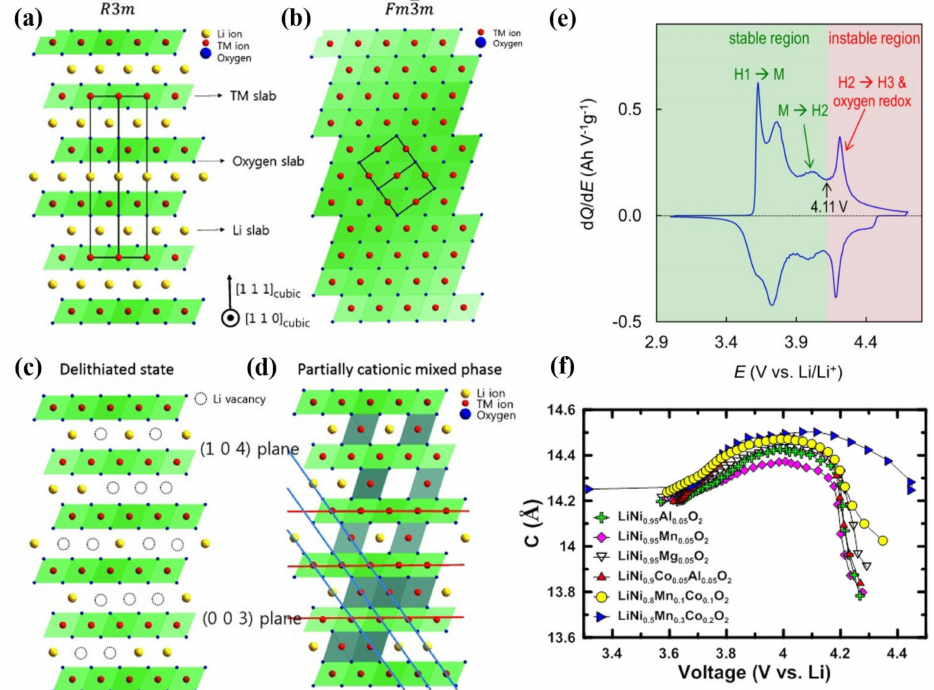
Figure 4. Schematic diagram of ordered and disordered phases and their structural transitions in layered lithium metal oxides. ( a ) Ordered R3m structure. ( b ) Cation mixing phase with Fm3 m structure. ( c ) R3 m structure with Li vacancies at highly charged state. ( d ) Cation mixed phase with partial TM ions in Li layer. Reproduced with permission from ref. [31]. Copyright 2015 John Wiley and Sons. ( e ) Typical dQ/dV curves for Ni-rich NCM/Li cells. Reproduced with permission from ref. [46]. Copyright 2020 Elsevier. ( f ) c–axis lattice parameter as a function of x in Li x MO 2 . Reproduced with permission from ref. [50]. Copyright 2019 American Chemical